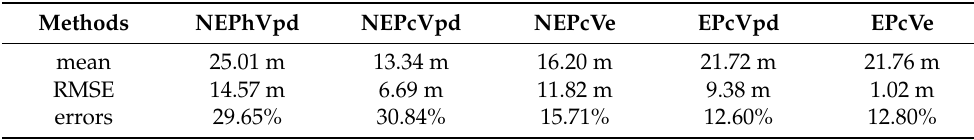
Table 2. Mean and RMSE values of forest height estimation results obtained using different methods based on X-band data.